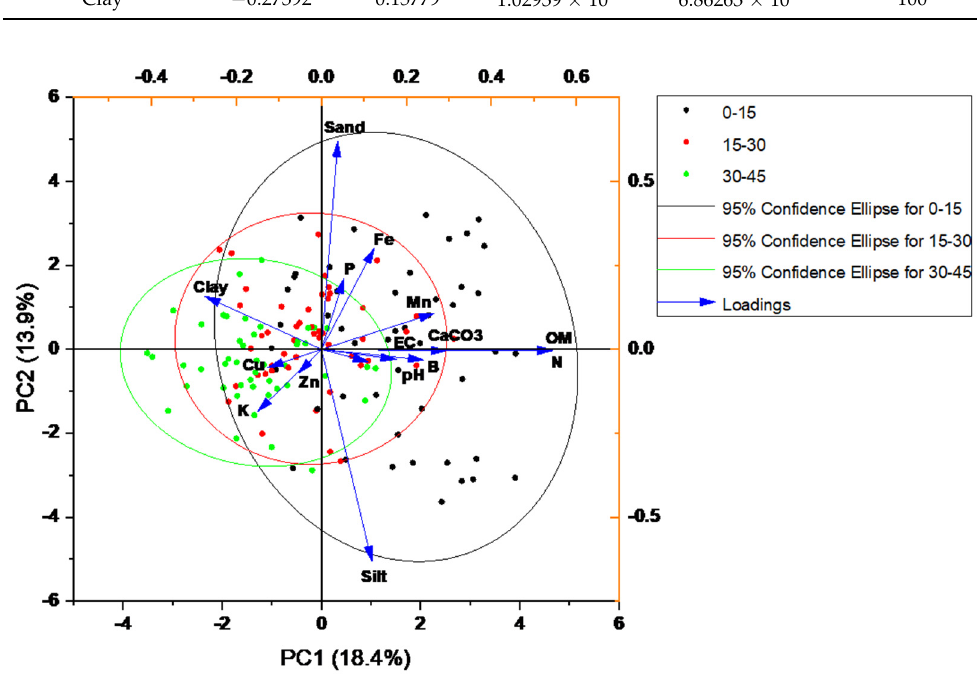
Figure 2. Principal component analysis for studied soil